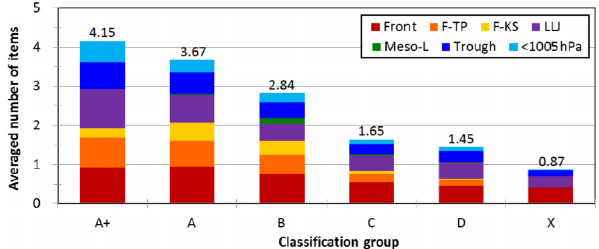
Figure 12. The average number of items met, among the seven items on the checklist, at the starting time of 24h segments for different classification groups (from A + , A to D, and X), with the value labeled on top. Following the order (bottom to top), the seven items are presence of surface Mei-yu front (front), front near Taipei (F-TP), front near Kaohsiung (F-KS), presence of LLJ, mesolow (meso-L), Taiwan inside a low-pressure zone (trough), and the mean sea-level pressure lower than 1005hPa ( < 1005hPa), re- spectively. The items are plotted in different colors (see insert) to show their